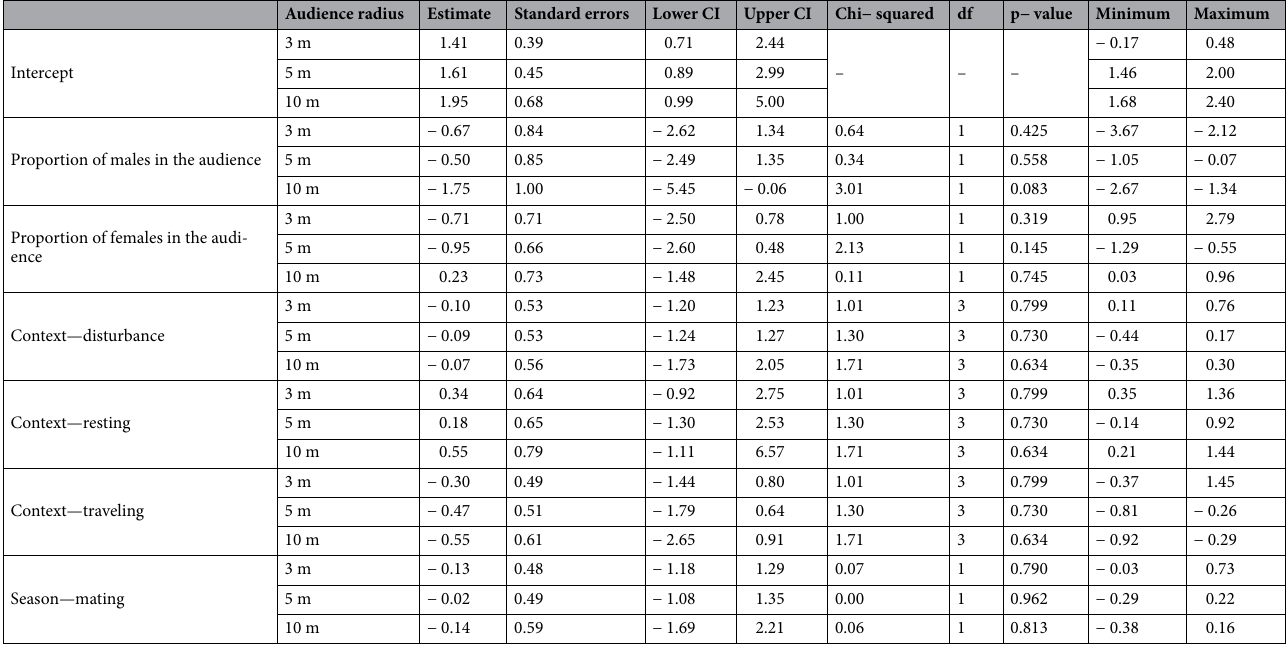
Table 2. Results of the models of the effects of audience composition within 3. 5 and 10 m radius, age, context and season on the probability that a female scent− marked when passing a marking